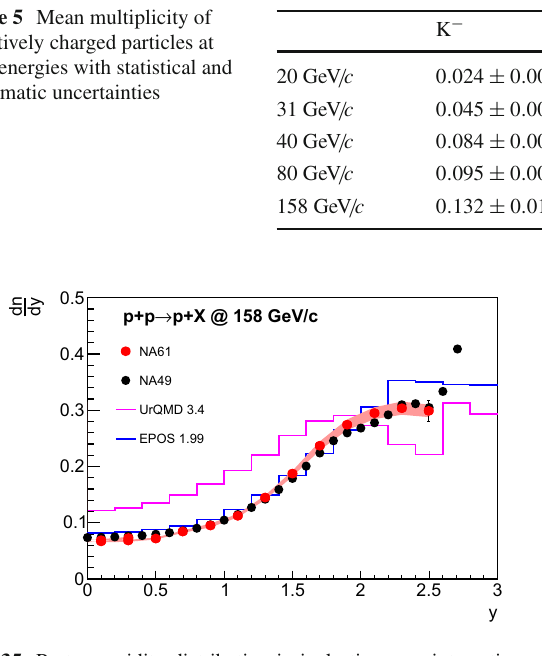
Fig. 35 Proton rapidity distribution in inelastic p + p interactions at 158 GeV / c compared with NA49 measurements [26] and predictions of the U r QMD [27,28] and EPOS [21]